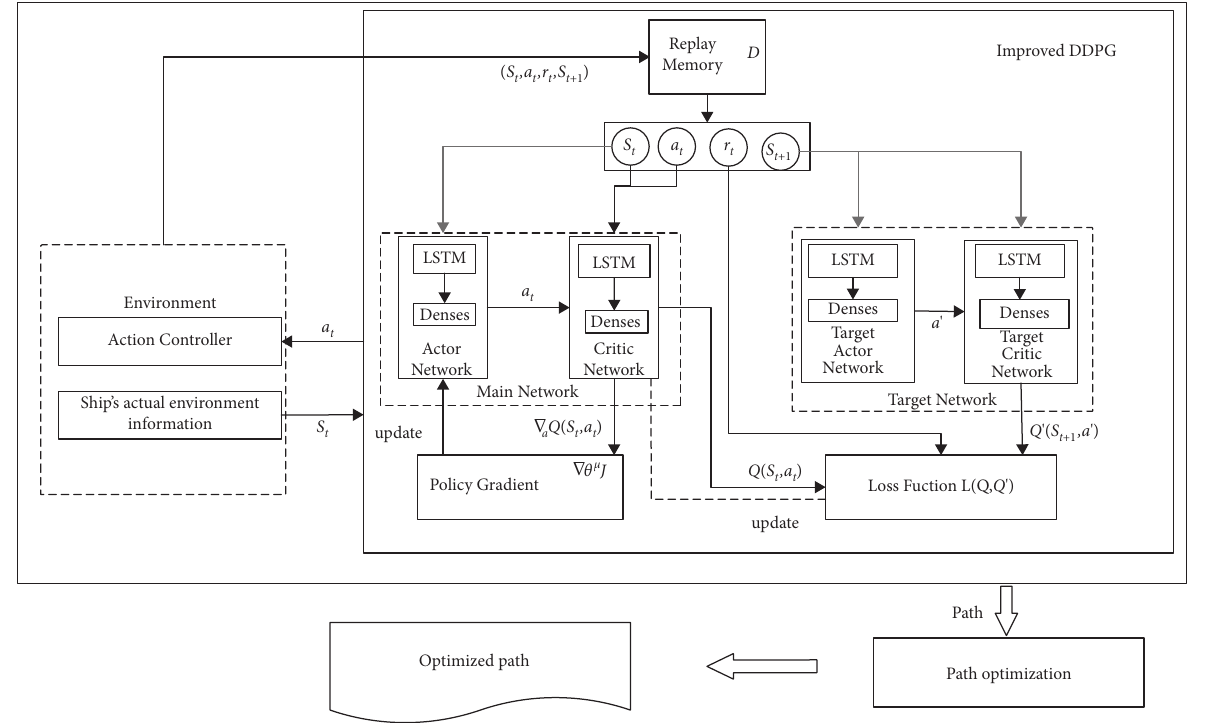
Figure 3: Ship path planning model based on improved DDPG.